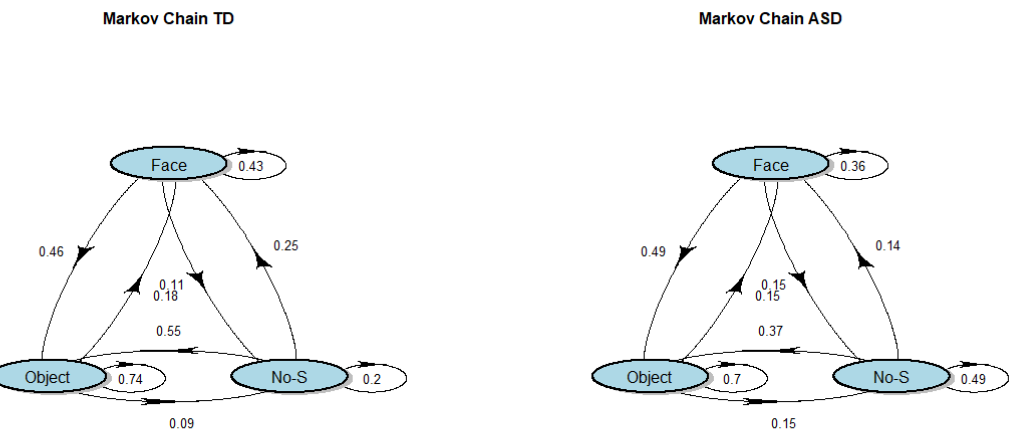
Figure 3. Graphical representation of Markov chains models of TD and ASD. Arrows represent transition direction. “No-S” stands for “No-stimulus fixation”